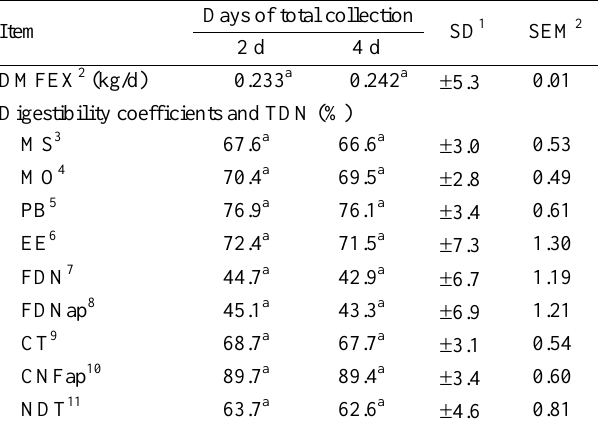
Table 6. Mean and coefficient of variation of fecal excretion of dry matter and digestibility of dry matter and nutrients estimated using two or four days of total collection in